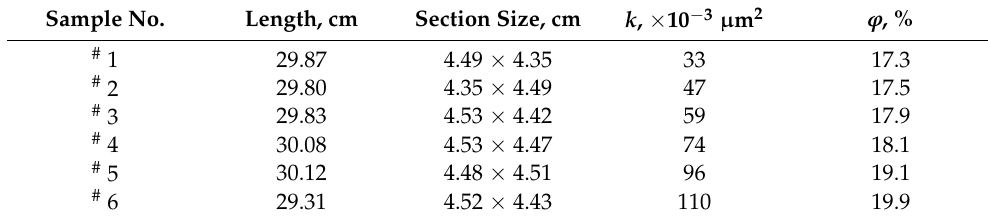
Figure 1. Photos of outcrop cores used ( # is the symbol representing the core number). Table 1. Petrophysical properties of core samples.